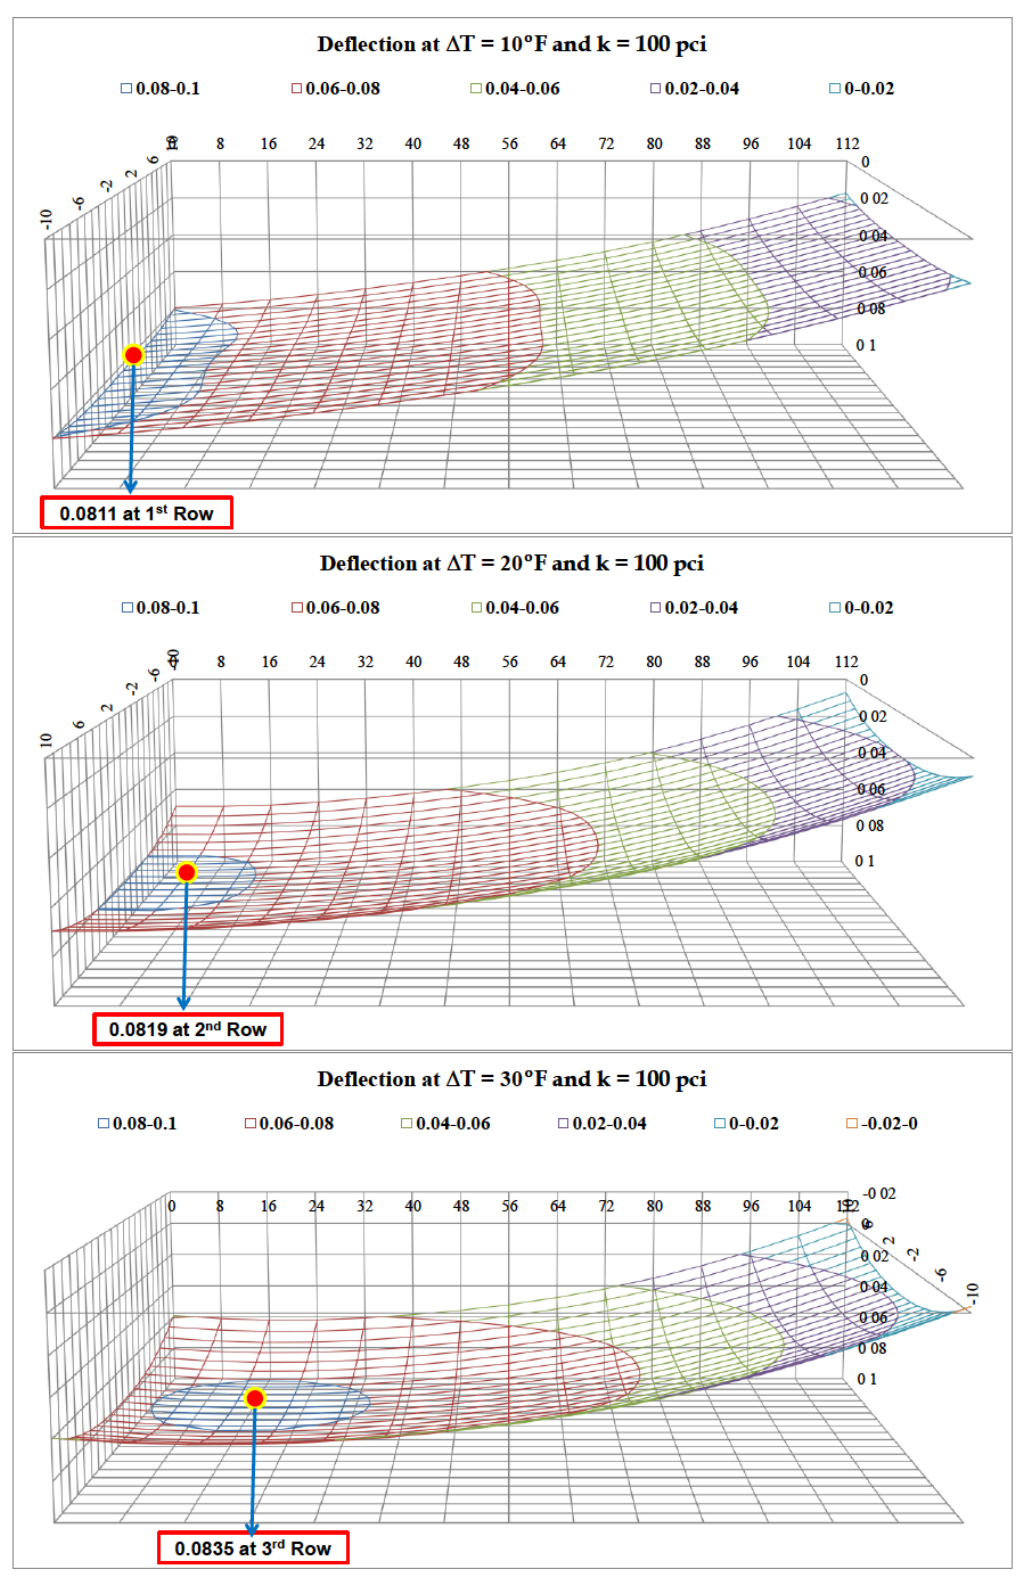
Figure 12: Deflection at the same k-value = 100 pci with different ∆